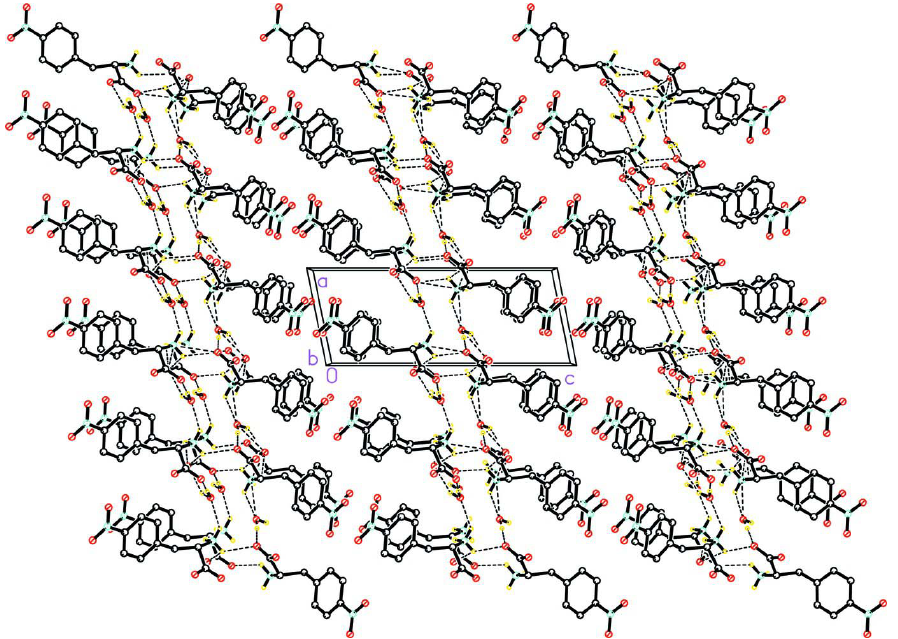
Figure 2 The crystal packing of the title compound viewed along the b axis. All hydrogen atoms not involved in hydrogen bonding (dashed lines) are omitted for